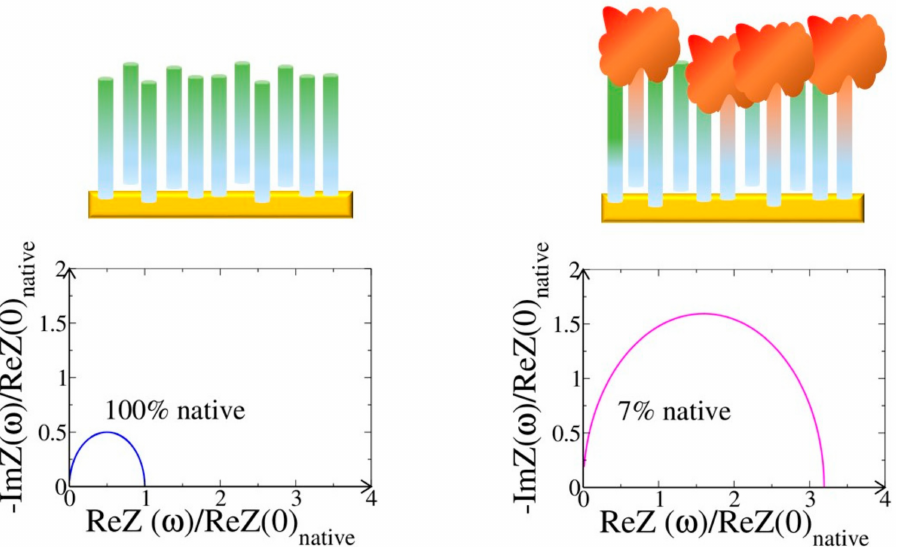
Figure 6. A sketch of an EIS measurement. On the top, an electrode functionalized with aptamers, before and after the injection of the receptor. On the bottom, the corresponding Nyquist plots calculated for a sample of aptamers in the native state and with 93% of the TBA-thrombin complex and 7% of TBA in the native state